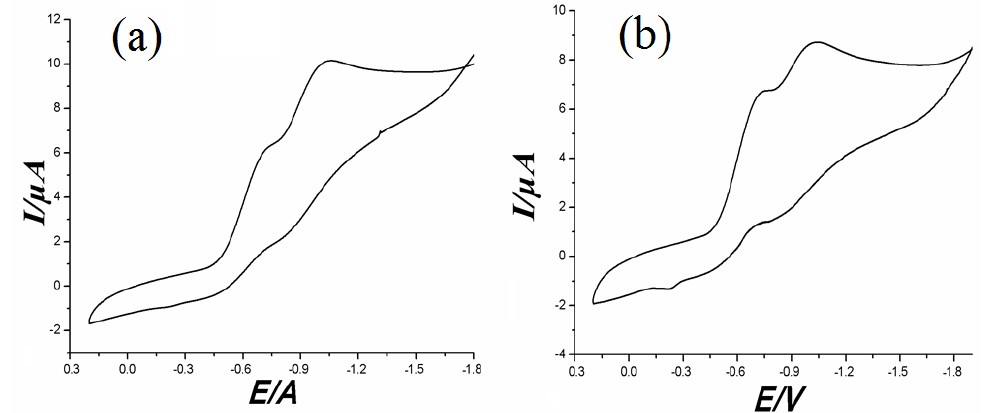
Figure 12. ( a ) Cyclic voltammograms of complex 1 measured at room temperature. ( b ) Cyclic voltammograms of complex 2 measured at room